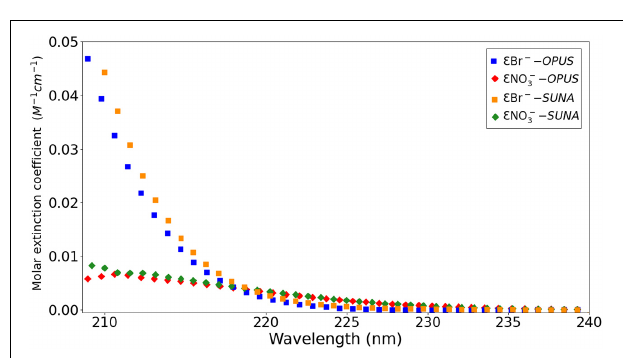
FIGURE 5 | Molar extinction coefficient ( ε ) values of 840 µ M Br − and 40 µ M NO 3 − at wavelengths from 210 to 240 nm at 20 ◦ C from OPUS and SUNA-specific (Johnson et al., 2018) calibration